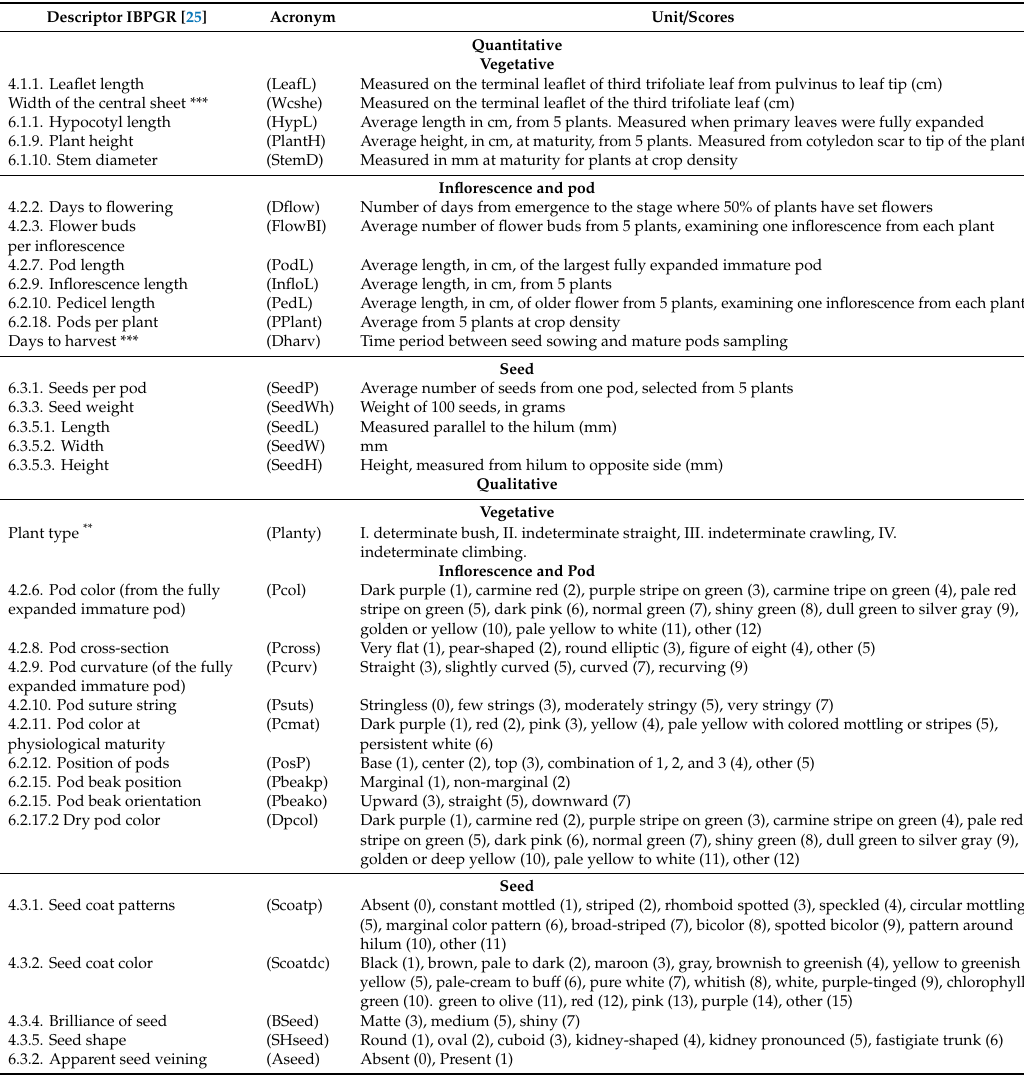
Figure 2. Solar radiation registered in the greenhouse during the autumn ( a ) and spring trials ( b ). Table 1. Quantitative and qualitative traits in the 24 Phaseolus vulgaris accessions. IBPGR—International Board for Plant Genetic Resources.